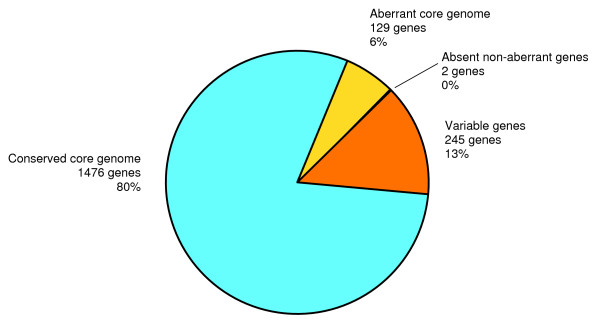
P. gingivalis core genome. Pie diagram representing all probes included in the results divided into pieces representing the conserved core genome, aberrant core genome and the variable genes. The percentages show the proportions of the total of functional probes. 80% of the strain W83 genes is present and conserved among the test strains. 6% of the W83 genes is present but aberrant and 13% of the genes is absent in at least one of the test strains. Two probes with very low signals were found as non-aberrant but absent.